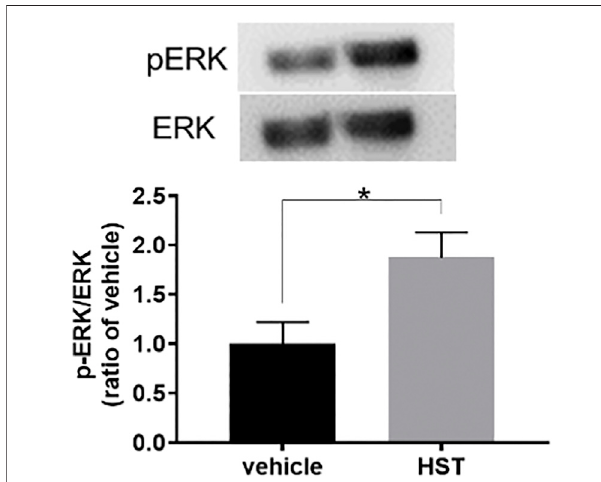
FIGURE 4 | Effect of Hangeshashinto (HST) on ERK phosphorylation in human oral keratinocytes (HOKs). HOKs were scratched and treated with vehicle or HST for 48 h. ERK expression was calculated using the ratio of the pERK-speci fi c band density/ERK-speci fi c band density determined by western blotting ( n (cid:2) 3). Data are expressed as the mean ± SEM. (bars). * indicates p < 0.05 compared with vehicle. Unpaired t -test.